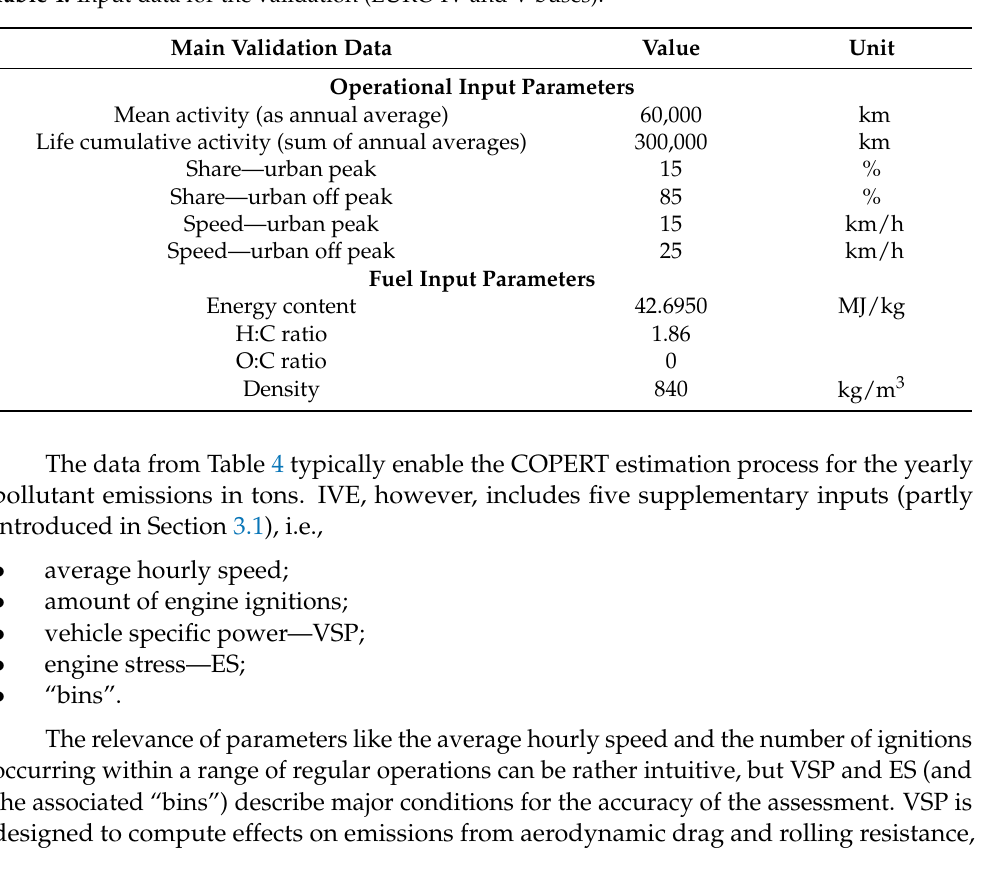
Table 4. Input data for the validation (EURO IV and V